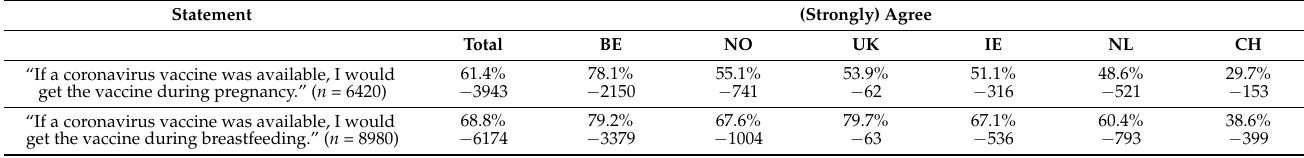
Table 2. COVID-19 vaccine willingness among pregnant and breastfeeding women.